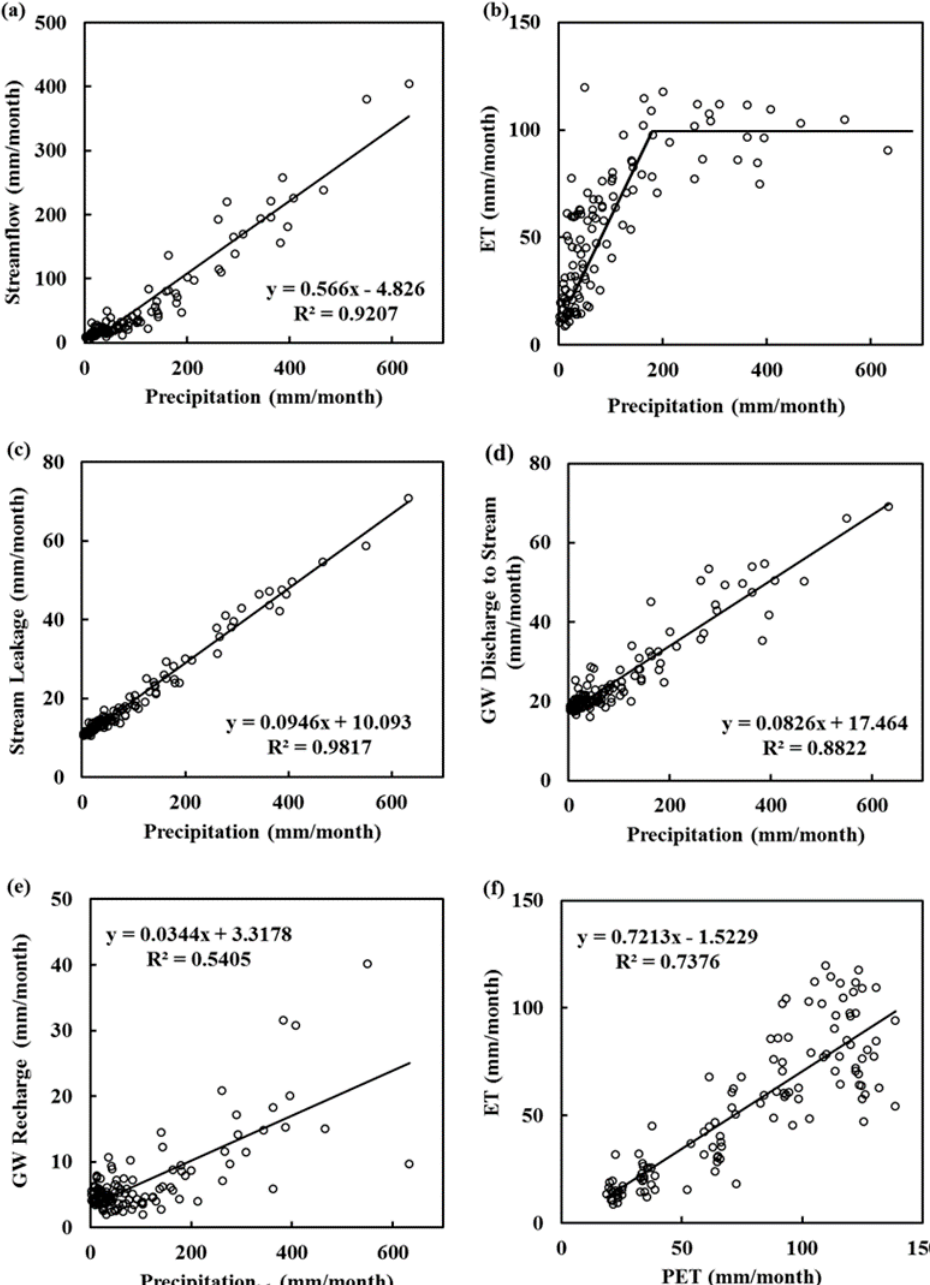
Figure 11. Correlations between the monthly precipitation and ( a ) monthly streamflow; ( b ) monthly ET; ( c ) monthly stream leakage; ( d ) groundwater (GW) discharge to the streams; and ( e ) monthly GW. ( f ) Correlation between the monthly potential ET (PET) and monthly ET.